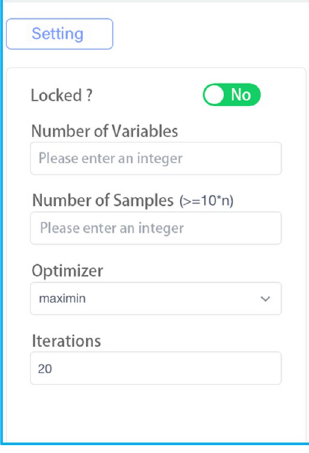
Figure 5 The main workplace screen of DADOS